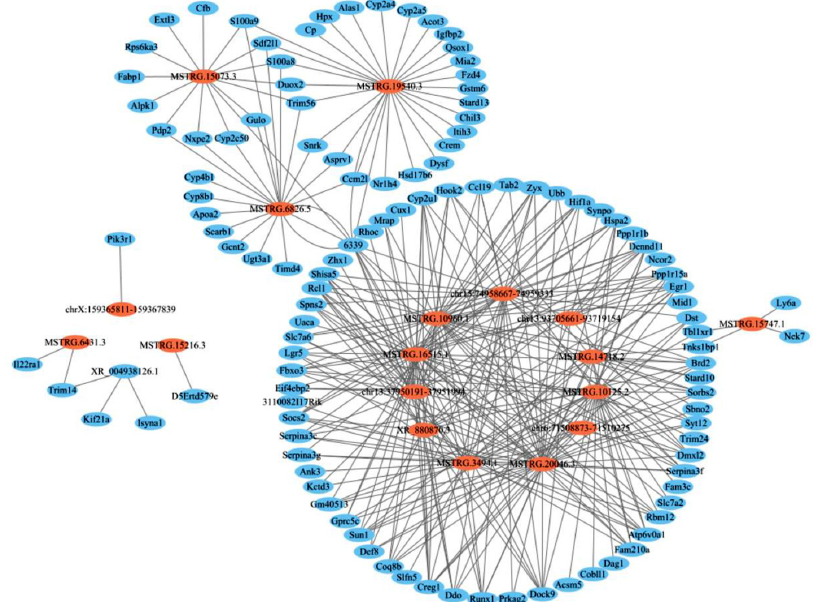
Figure 5. LncRNA (orange) and mRNA (blue) differential gene co-expression networks in the liver.